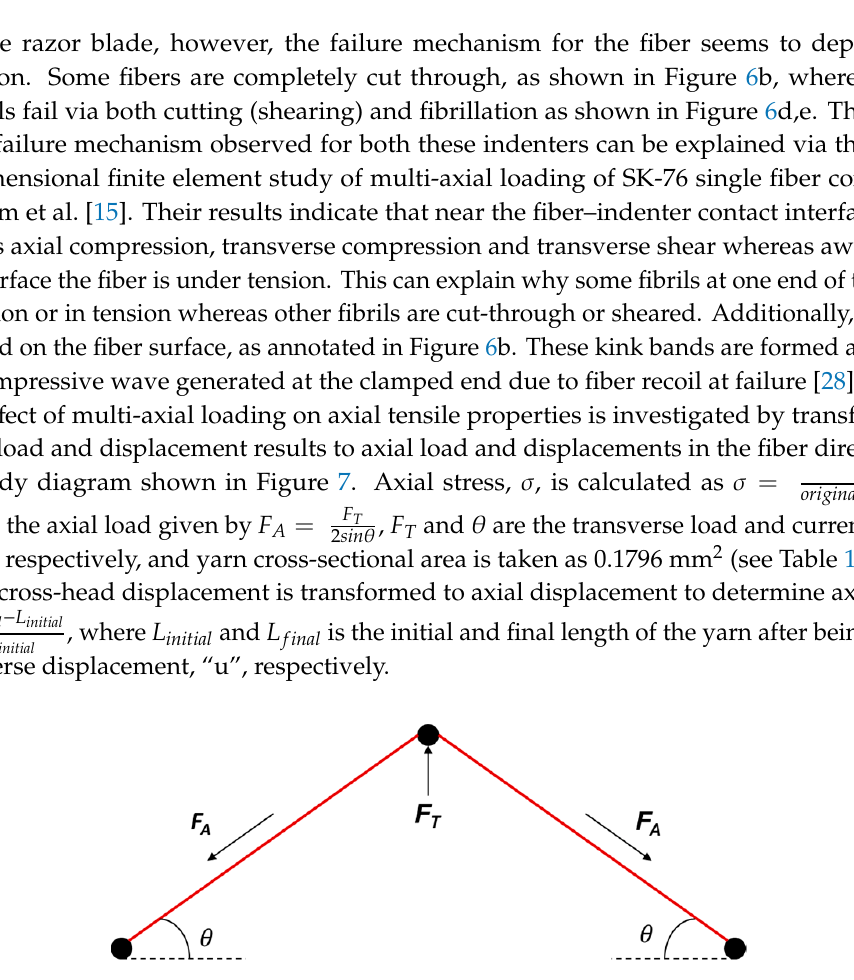
Figure 7. Free body diagram of transverse loading experiment.